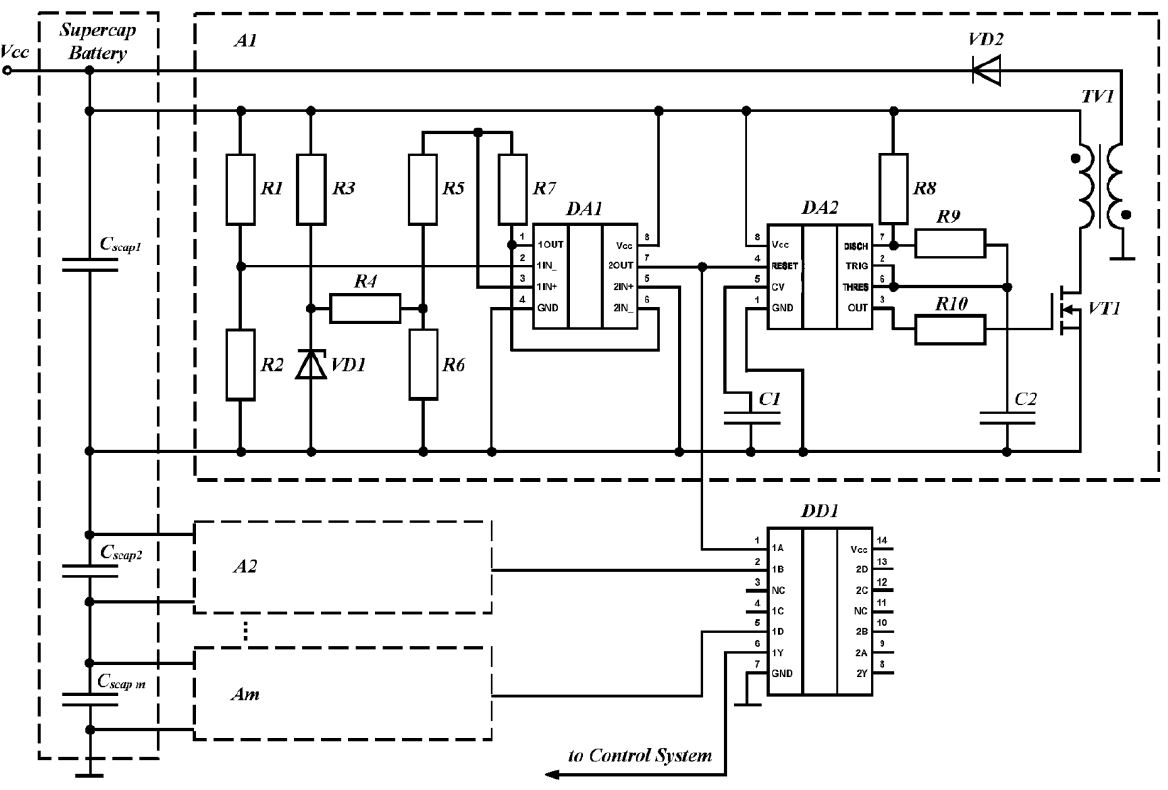
Fig. 6. The energy storage circuit.